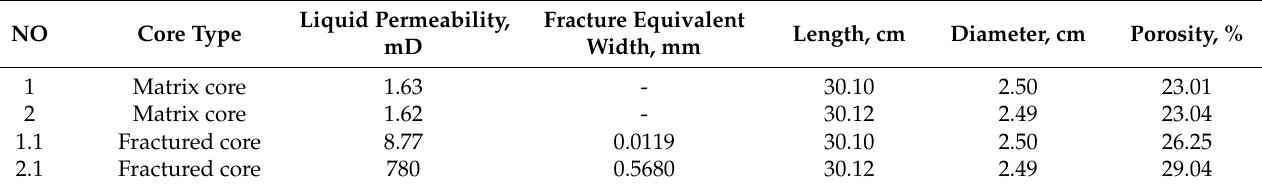
Figure 2. Main experimental flow chart. The experiment used fractured core and matrix core are shown in Table 1. Table 1. The parameters of fracture core and matrix core.